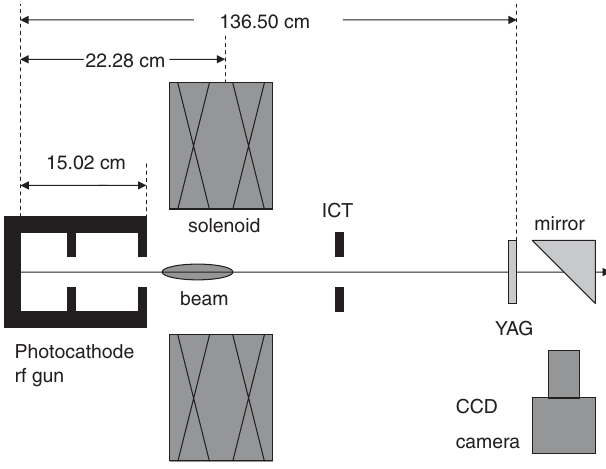
FIG. 3. Layout of the phase space mapping